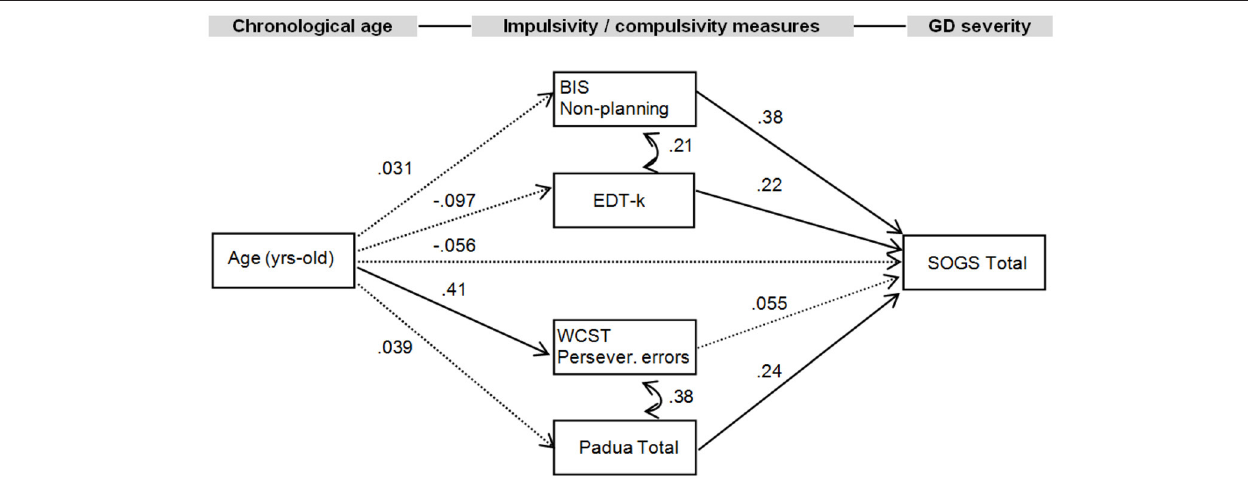
FIGURE 1 | Path diagram with structural equation modeling showing standardized coefficients ( N = 132). Continuous parameter: significant parameter. Dash line, non-significant parameter; BIS-11, Barratt Impulsiveness Scale; EDT, Experiential discounting task; WCST, Wisconsin Card Sorting Test; SOGS, South Oaks Gambling Screen; Persev.,